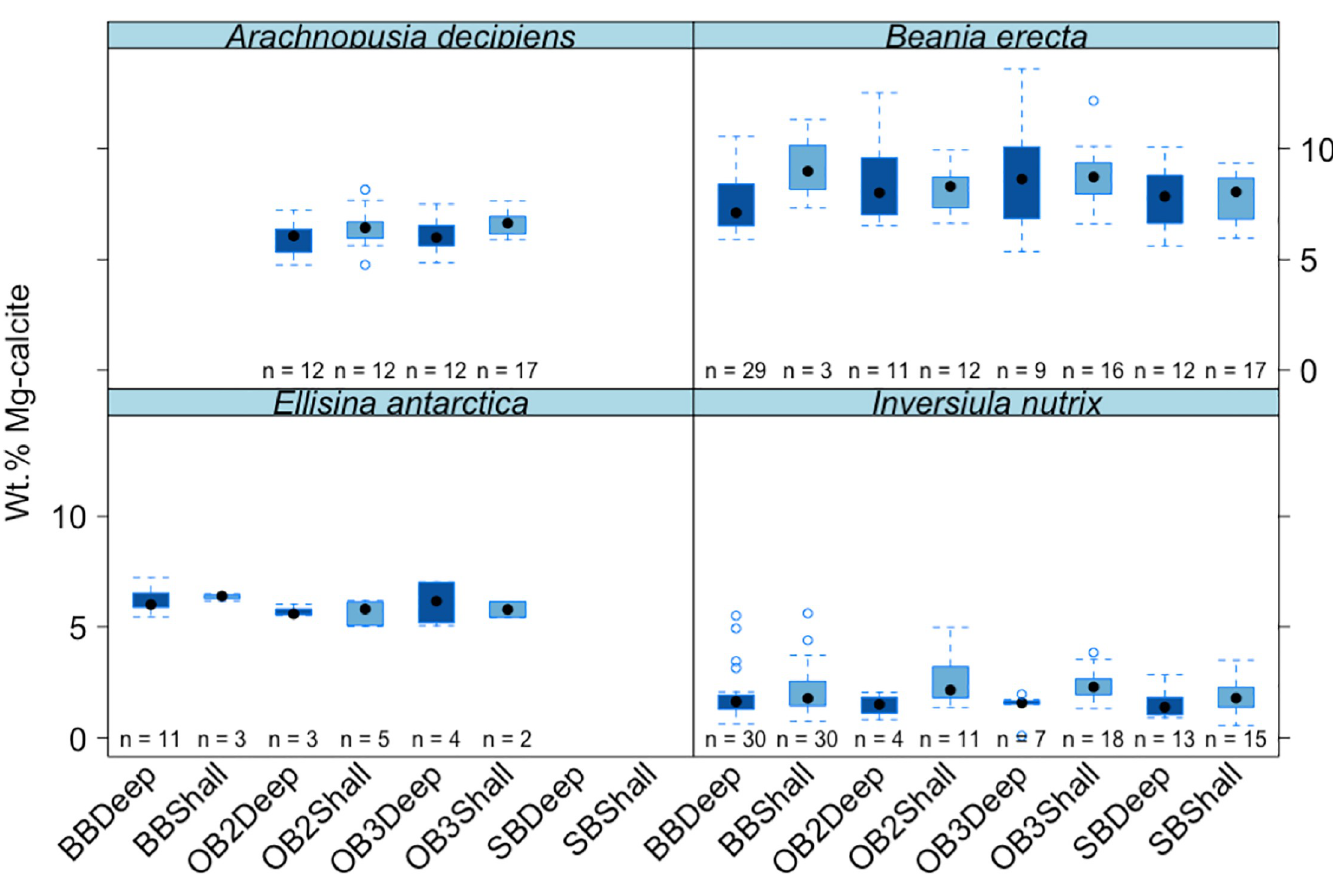
Fig 5. Mean values ( ± standard error) of wt% MgCO 3 in calcite in the four Antarctic cheilostome species among different sites and depths. Boxes depict standard deviation around mean (mid-line); tail indicates range. Colours indicate deep and shallow waters. � Brown Bay = BB , OB2 = O'Brien Bay -2 , OB3 = O’Brien Bay-3 , SB = Shannon Bay . Deep = Deep , shallow = Shall